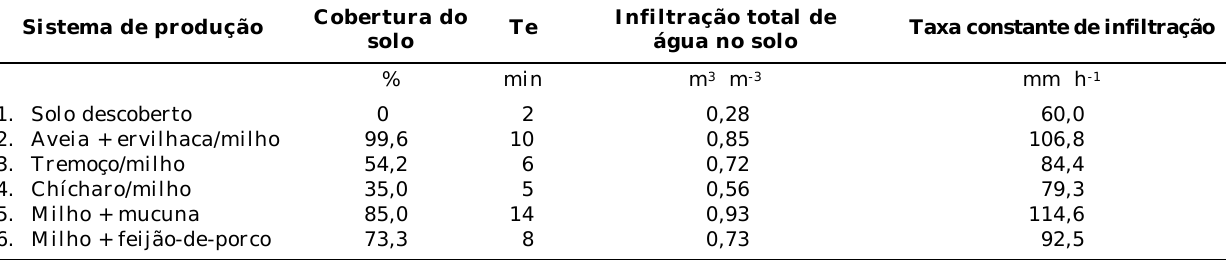
Quadro 3. Tempo para o início da enxurrada (Te), infiltração de água no solo e taxa constante de infiltração, através de chuva simulada, nos sistemas de produção de milho. Média de duas